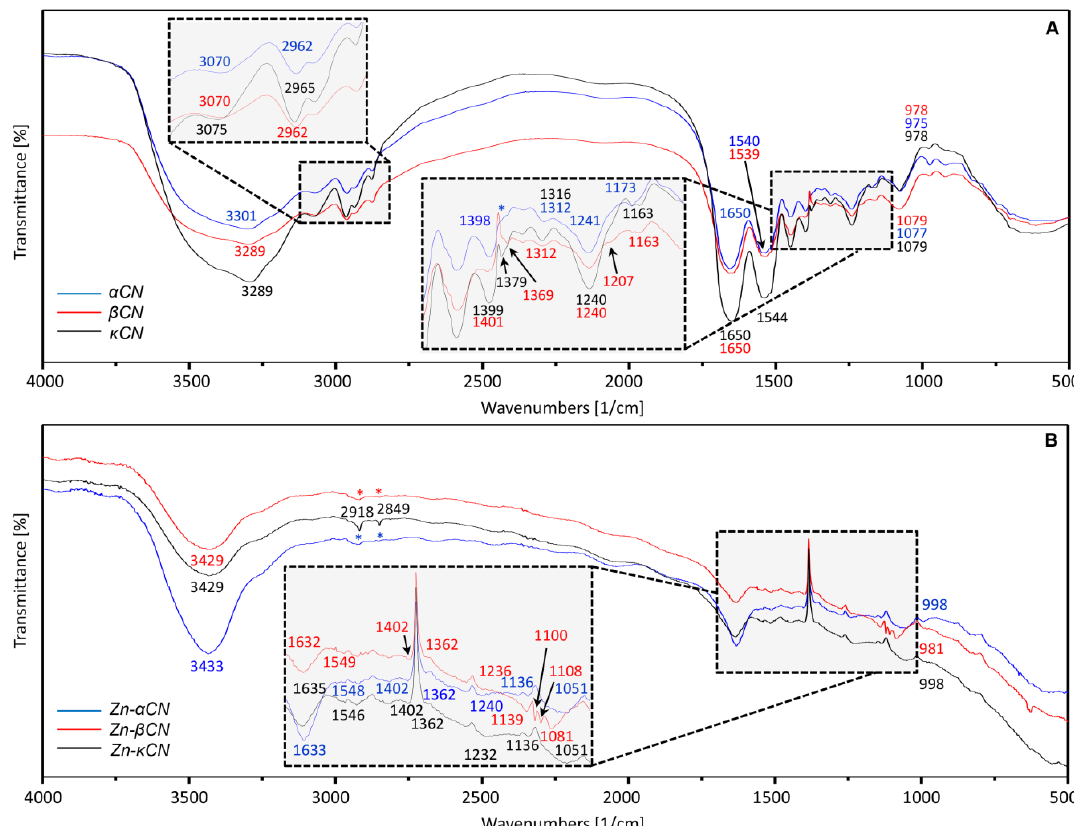
Figure 4. Infrared spectra of the α S1 CN, βCN and κCN casein isoforms control ( A ) and casein isoforms after binding of zinc ions ( B ). Asterisks (*) indicate signal disappearance.